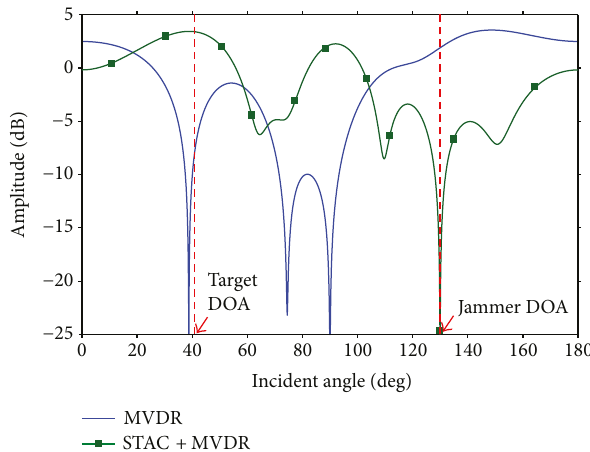
Figure 9: Beampatterns obtained from the simulated